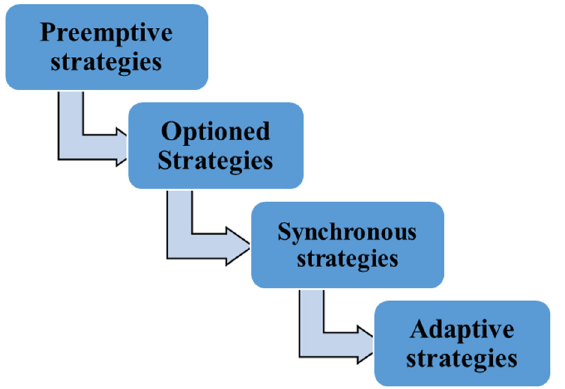
Figure 1. Entrepreneurial Strategies. Source: Author configuration based on the literature reviewed.